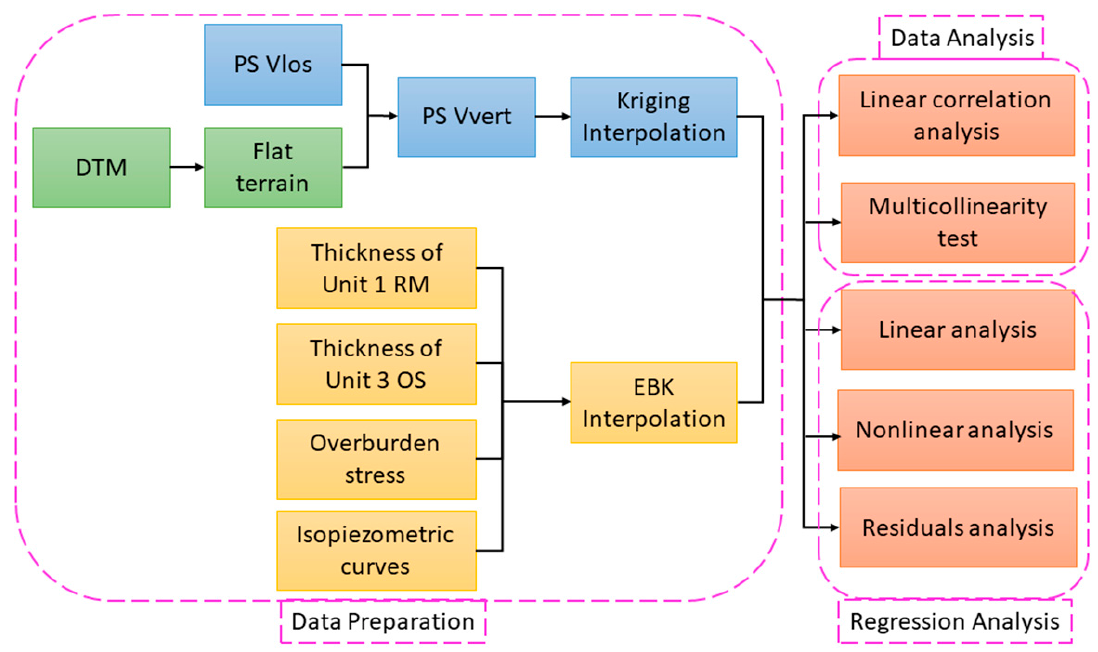
Figure 4. Flowchart of the three-phase procedure. The abbreviations stand for: Persistent Scatterers (PS), velocity along the satellite line of sight (V los ) or the vertical direction (V vert ), Digital Terrain Model (DTM), reworked material (RM), organic silts (OS) and Empirical Bayesian Kriging (EBK).